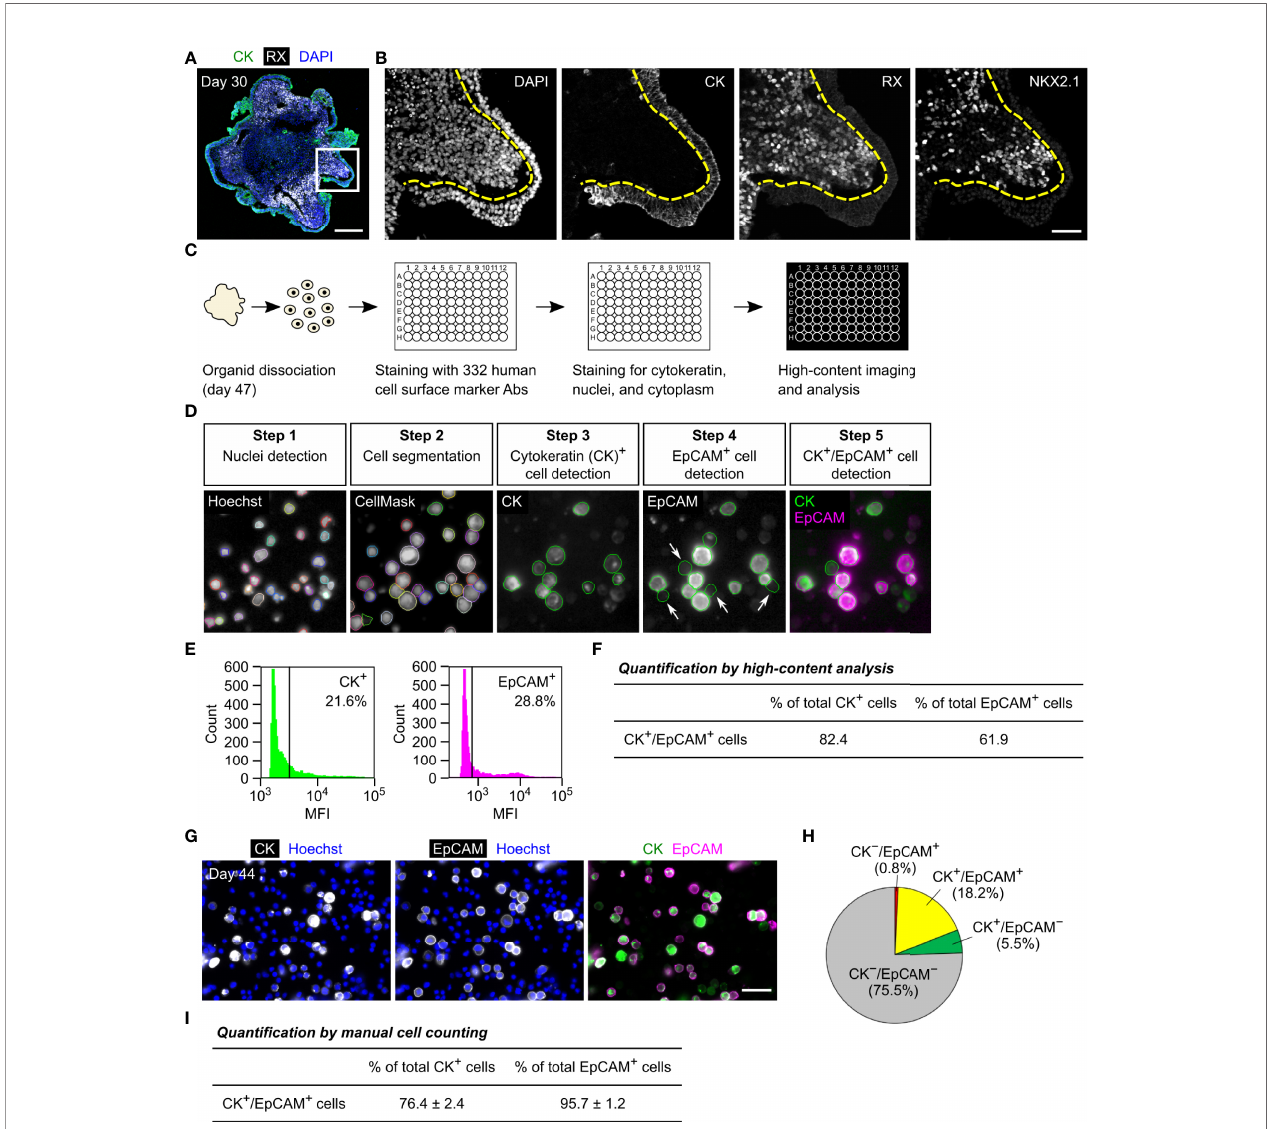
FIGURE 1 | Identi fi cation of EpCAM by surface marker screening of OE cells in HP organoids. (A, B) Triple immunostaining of a day-30 HP organoid for cytokeratin (CK), RX, and NKX2.1. Nuclei were stained with DAPI. Staining for NKX2.1 is omitted in (A) . Magni fi ed views of the boxed region are presented by monochrome images in (B) . Dashed lines show the boundary between the cytokeratin + OE layer and RX + /NKX2.1 + hypothalamic NE. (C) The work fl ow of the screening experiment. Ab: antibody. (D) Representative images of the high-content analysis. Cells were stained for nuclei (Hoechst), cytoplasm (CellMask), cytokeratin, and EpCAM. Arrows indicate false-positive EpCAM + cells caused by the contamination of fl uorescence signals from contiguous EpCAM + cells. (E) The mean fl uorescence intensity (MFI) of respective cells in the channels of cytokeratin (left) and EpCAM (right). The vertical lines indicate thresholds that separate positive and negative cell fractions. These threshold settings were consistently used for the high-content analysis. (F) The percentage of cytokeratin + /EpCAM + double-positive cells among total cytokeratin + or EpCAM + cells. These parameters were automatically quanti fi ed for all of the tested surface markers, and therefore EpCAM was only identi fi ed as the surface marker for which both parameters exceeded 60%. (G) Double immunostaining of suspension cells dissociated from day-44 HP organoids for cytokeratin and EpCAM. (H) The percentages of cytokeratin and EpCAM double-positive, single-positive, and double-negative cell populations quanti fi ed by manual cell counting. The values represent the mean of four independent experiments on days 44 – 51. (I) The percentage of cytokeratin + /EpCAM + double-positive cells among total cytokeratin + or EpCAM + cells. The values were calculated from the same dataset in (H) . Scale bars: 200 µm (A) , 50 µm (B, G)